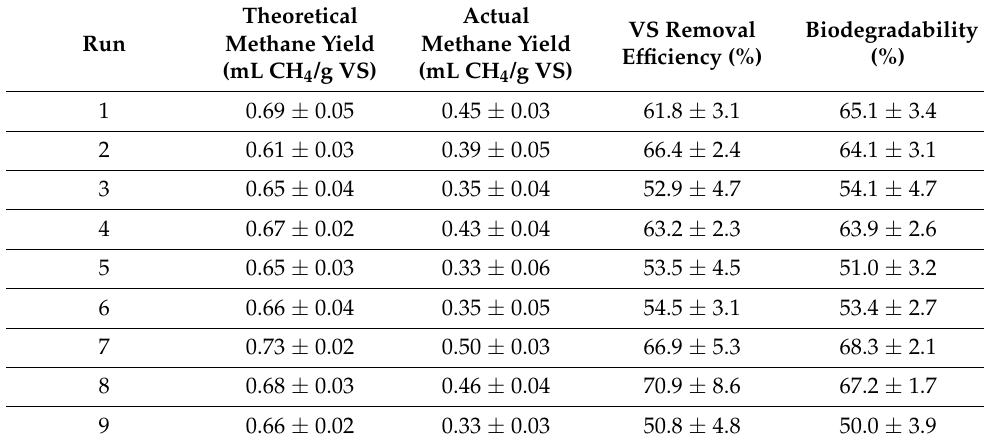
Table 6. Volatile solids (VS) removal rate and biodegradability according to the mixing